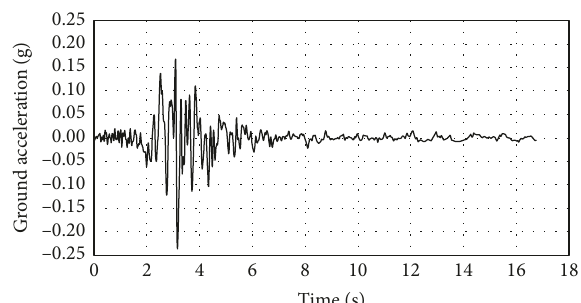
Figure 5: Record 147ya—Friuli (aftershock), 1976, September 15 th .